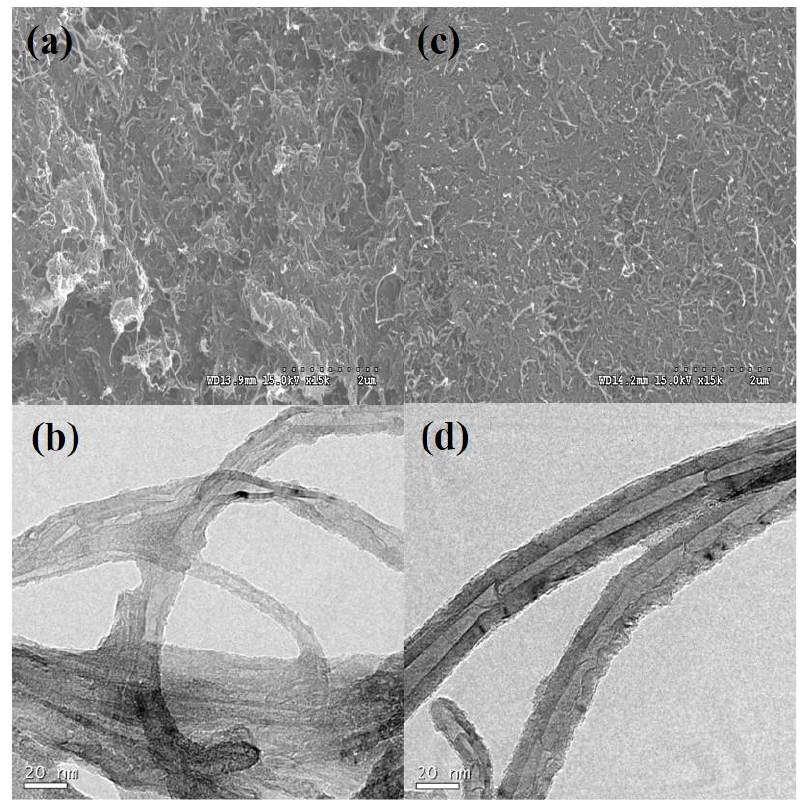
Figure 3. FESEM images of MWNT – APDMS with ( a ) and ( b ) before washing excess APDMS, ( c ), and ( d ) after washing excess APDMS.